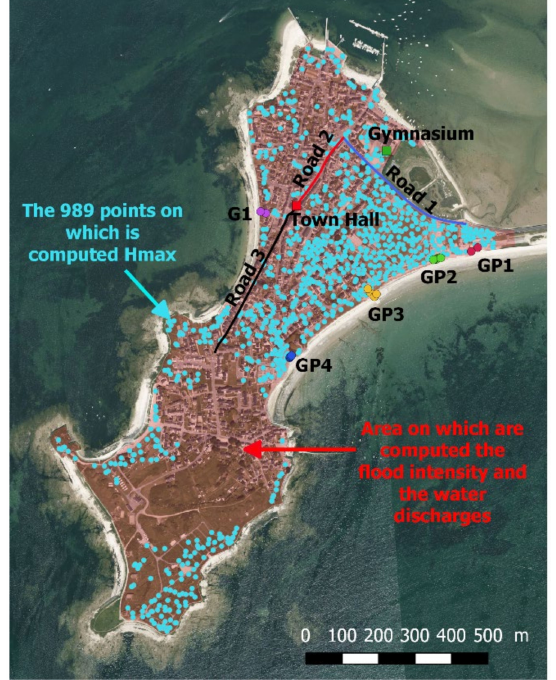
Figure 2. Localisation of the predicted physical quantities Y i (listed in Table 2) used to estimate the indicators I j (listed in Table 1).